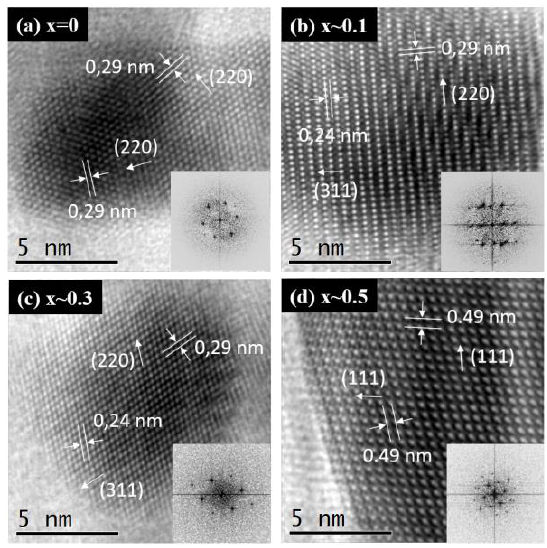
Figure 3. High resolution TEM images of Zn x Fe 3−x O 4 MNPs with different stoichiometry ( a ) x ~ 0, ( b ) x ~ 0.1, ( c ) x ~ 0.3 and ( d ) x ~ 0.5. The inset represents the 2D Fast Fourier Transform (FFT).